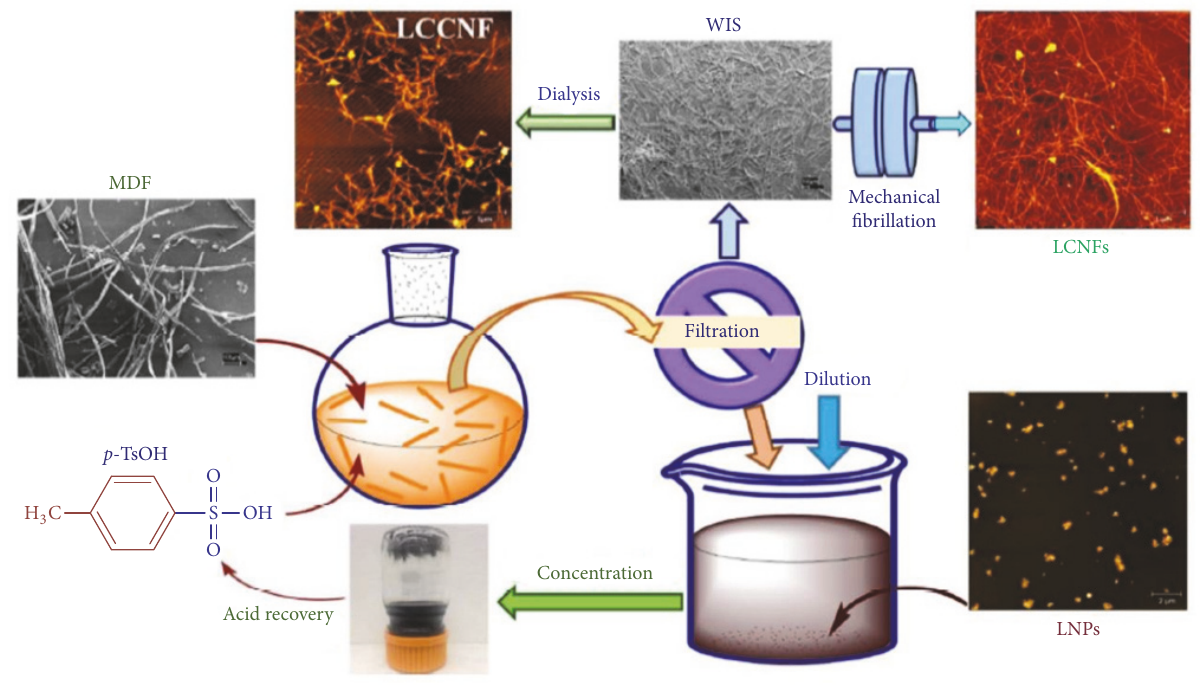
Figure 10: Schematic diagram of the preparation of LCNFs and LNPs by using 𝑝 -TsOH pretreatment